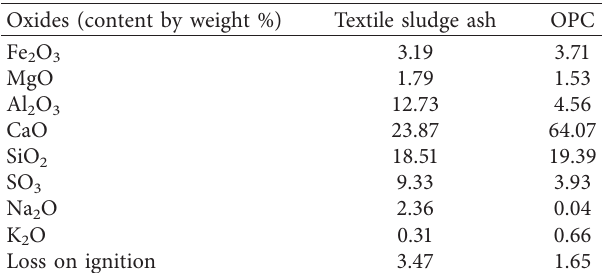
Table 2: Chemical composition of textile sludge ash and cement.